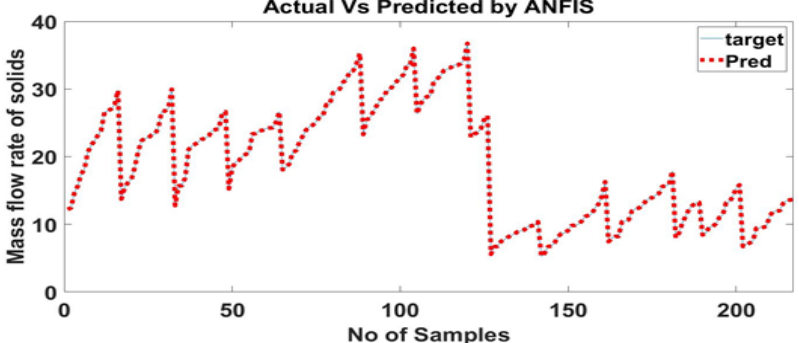
Figure 12. Comparison of Experimental and Predicted output of